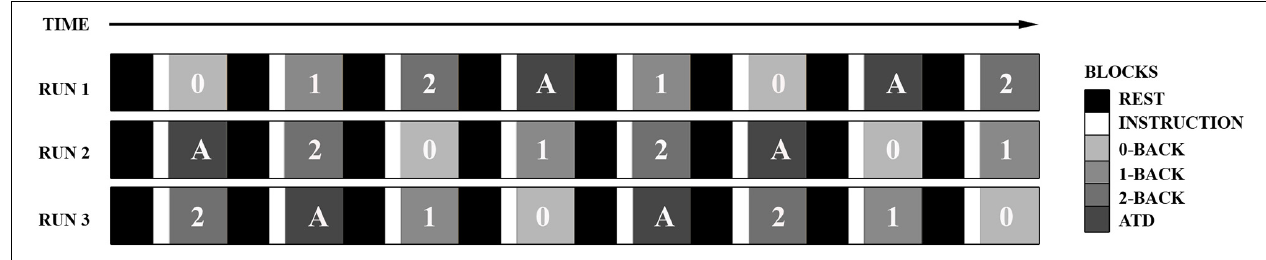
FIGURE 1 | The scanning protocol utilized a block design. Each experimental block (30 TR) was proceeded by a resting baseline condition (20 TR) and every experimental block was initiated by task instruction (7 TR). The figure depicts the presentation order of the experimental conditions which were partially counterbalanced over the entire experiment and divided into three runs of eight task blocks (3 × 456 TR). Each experimental condition was presented twice per